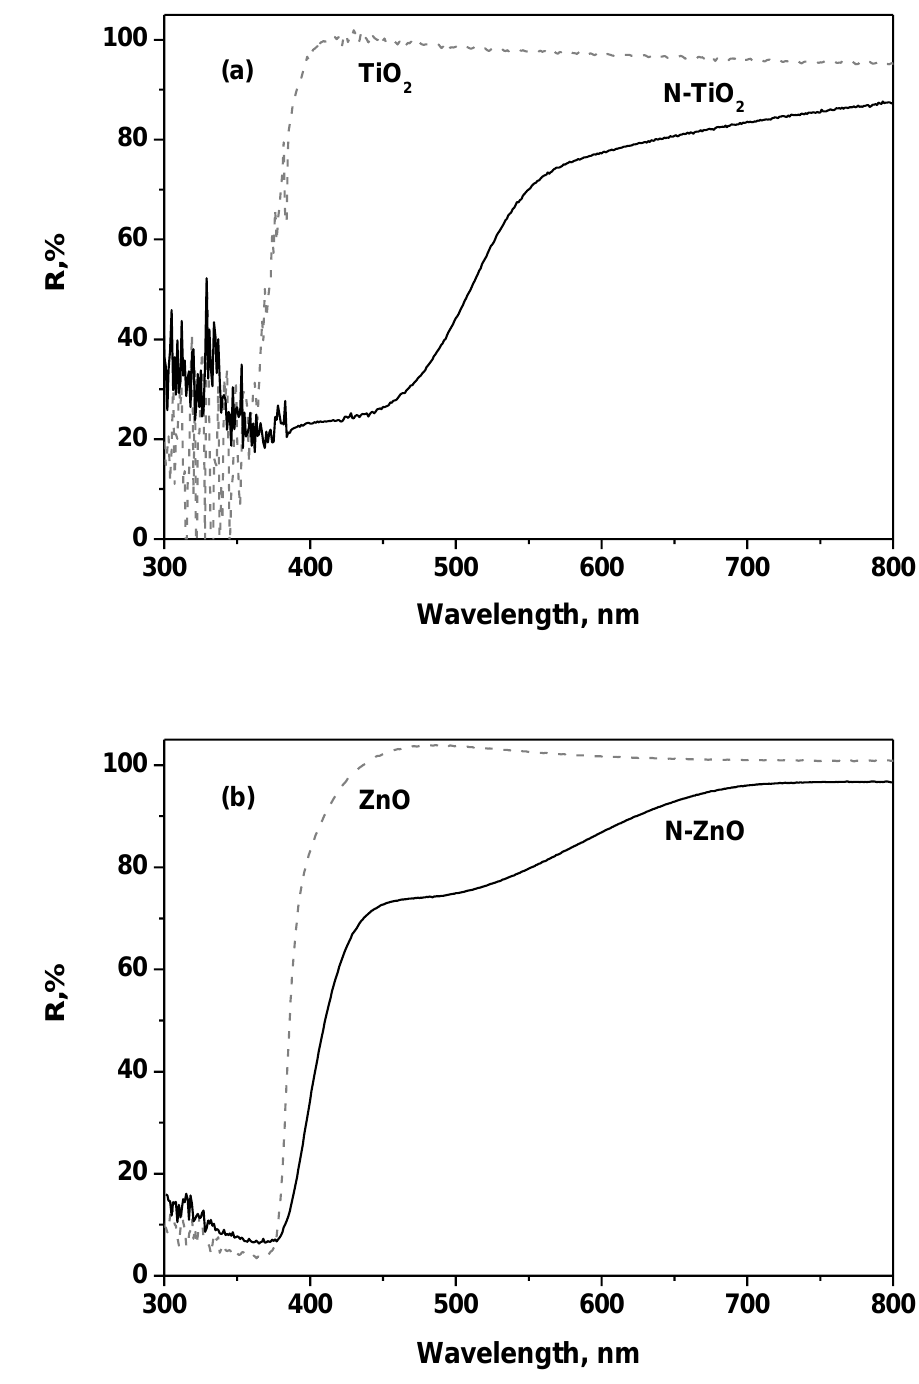
Figure 1. UV-Vis DRS spectra for ( a ) TiO 2 and N-TiO 2 , as well as ( b ) ZnO and N-ZnO samples.